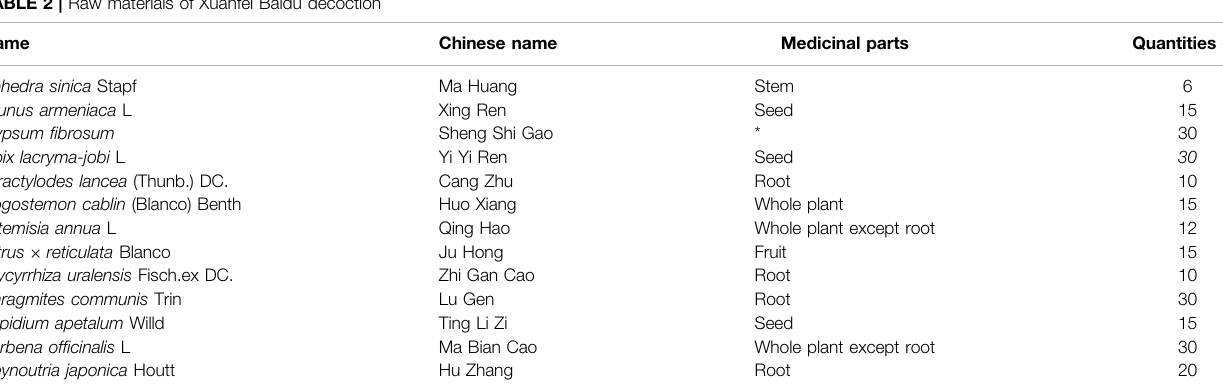
TABLE 2 | Raw materials of Xuanfei Baidu